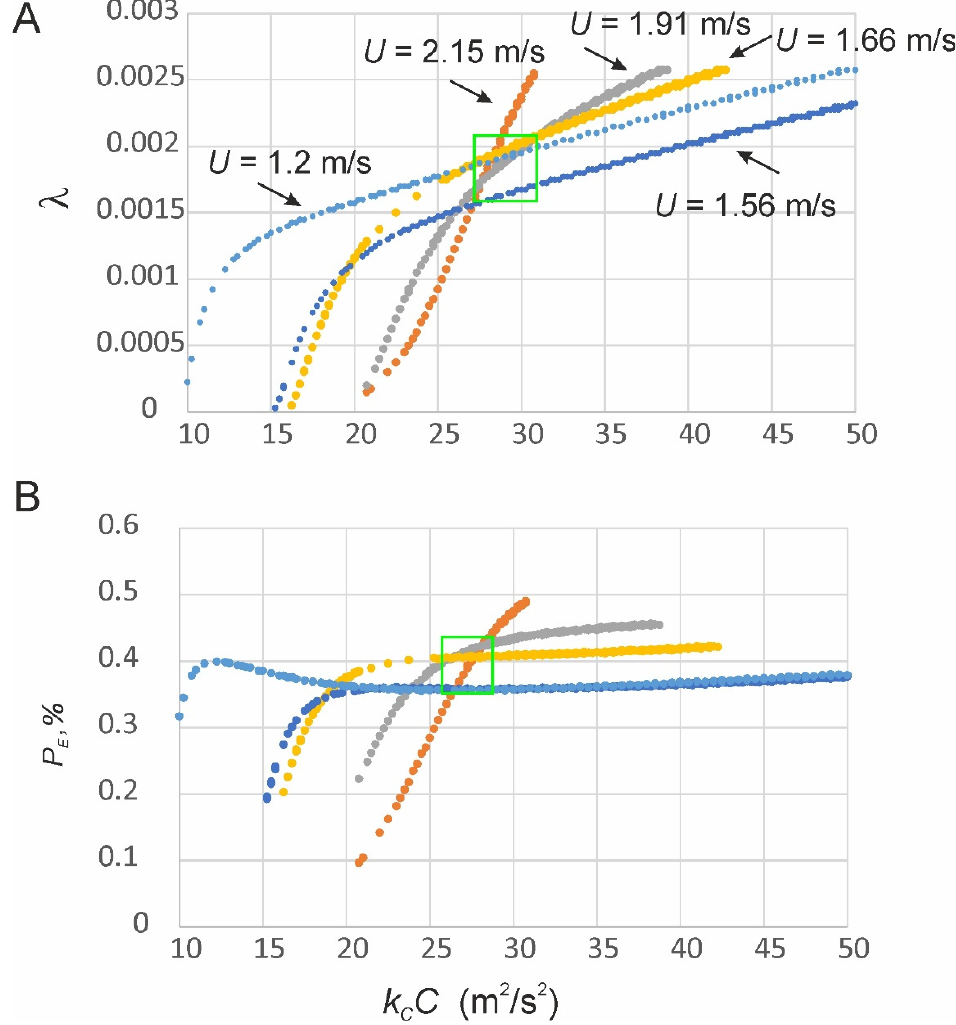
Figure 8. The possible combinations of initial specific soil cohesion force ( k C C, m 2 /s 2 ) with parameter λ in the failure function, which lead to the same resulting erosion rate at a given flow velocity ( A ), and of the percentage of the area, occupied by erodible soils after 3600 s of the armoring–loosening cycles P E ,% ( B ). The green box shows the possible range of soil properties, which fits the measured flow velocity and erosion rate in plot 2.